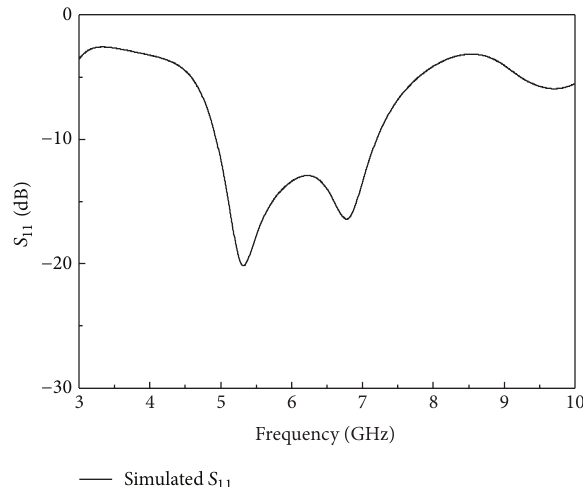
Figure 2: Simulated 𝑆 11 of the proposed Vivaldi element.